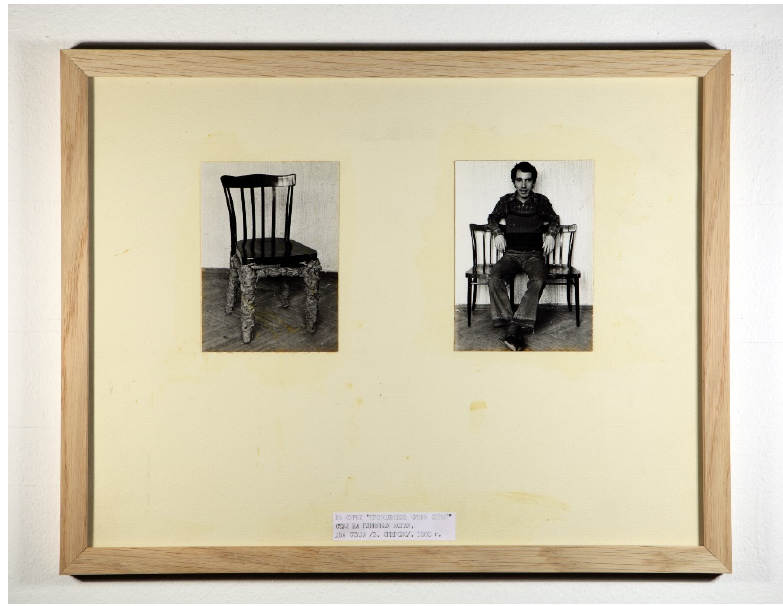
Figure 16. Albert. Chair on Clay Legs and Two Chairs (V. Skersis) . Paper, black-and photographs. 36 cm × 48 cm. Courtesy of the artist.